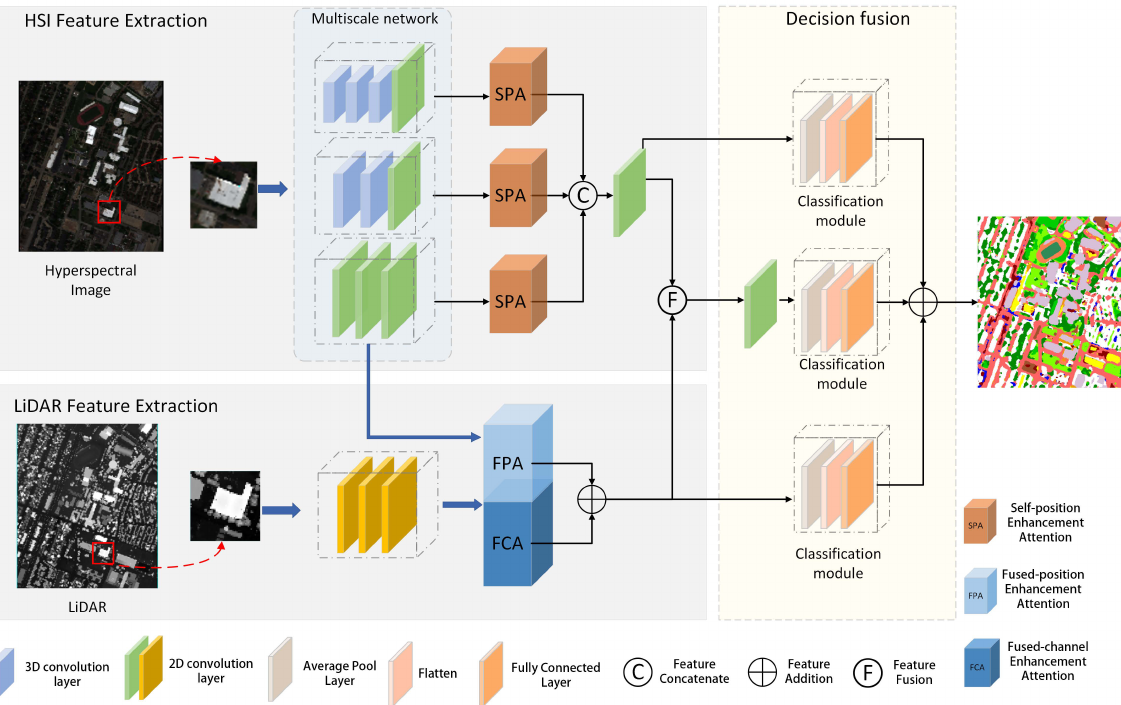
Figure 1. Proposed classification framework of PC 2